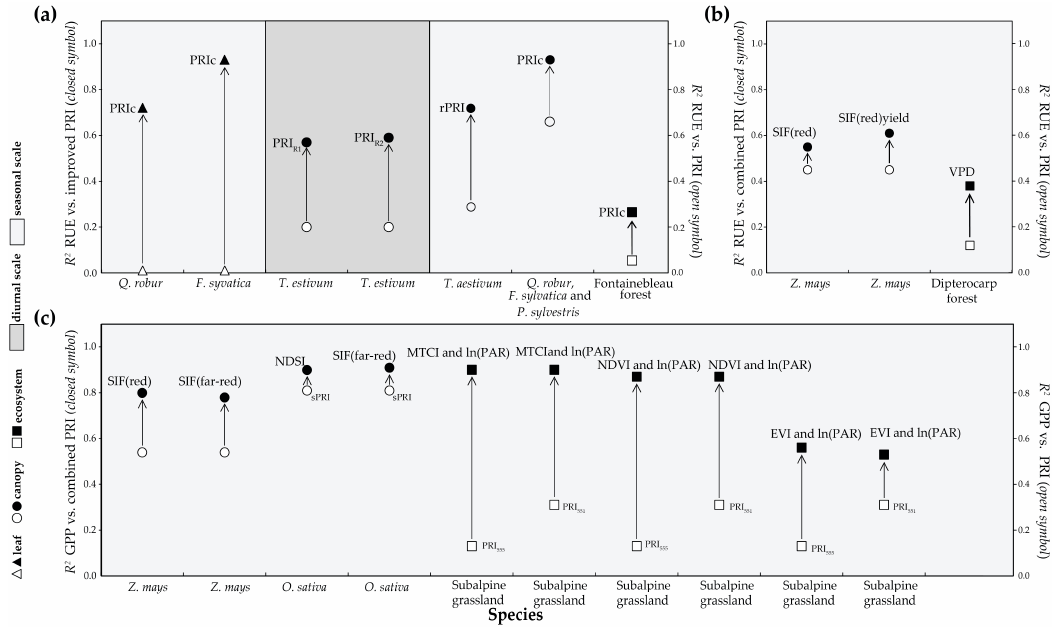
Figure 10. Comparison of the relationships between RUE/GPP vs. PRI and RUE/GPP vs. improved/combined PRI. ( a ) PRIc was used for Q. robur and F. sylvatica [86], a mixed canopy of Q.